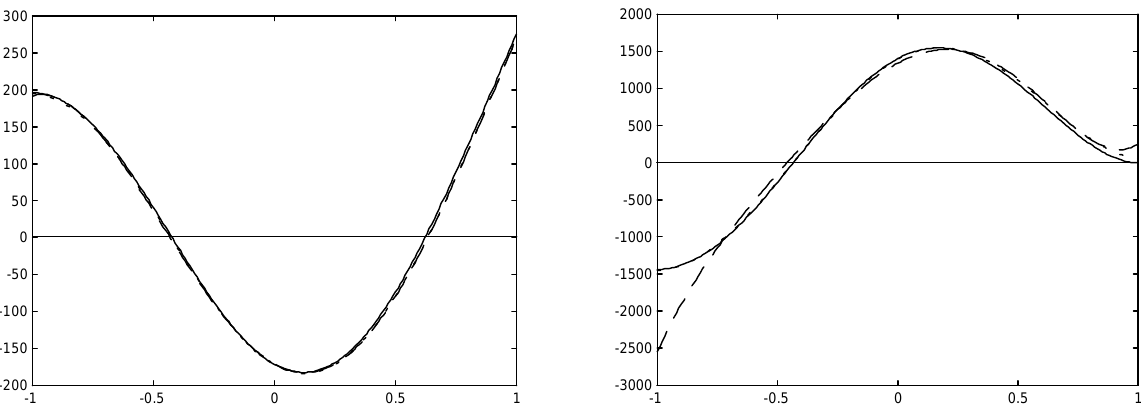
Fig. 4. Mode 3 deflected form (LHS) and curvature (RHS) for a Free-Free Beam. LDV scan between the centre and the tip: Theoretical (full line), Initial measurement (dashes), Final iteration (dotted).